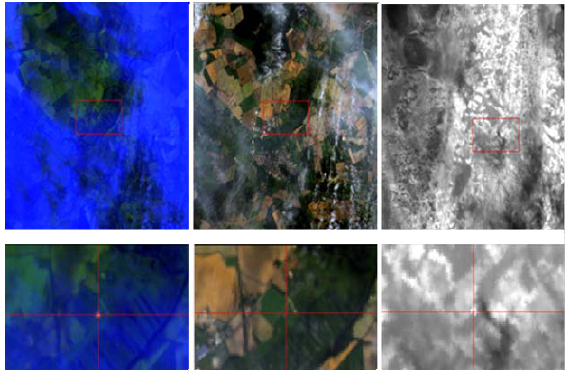
Figure 2: Overview of the DEMMIN (top row). Zoom on the test fire in the lower row. Left: Landsat 8 RGB: bands 7,6,9. Middle: L-8 RGB: band 4,3,1. Right: TET-1 MWIR band. The results show the ability to detect comparable small fires (Figure 2). Image based fire radiative power resulted in 2.240 MW (vs. calculated 1.36 MW), which seems feasible,